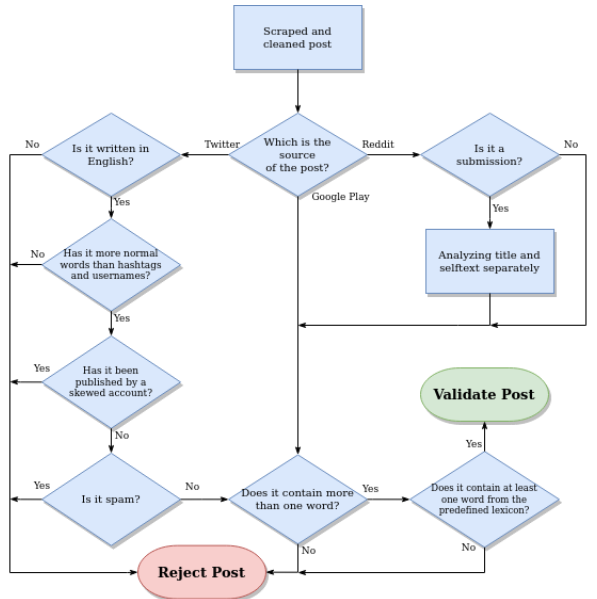
Figure 2. Rule-based Validation Process